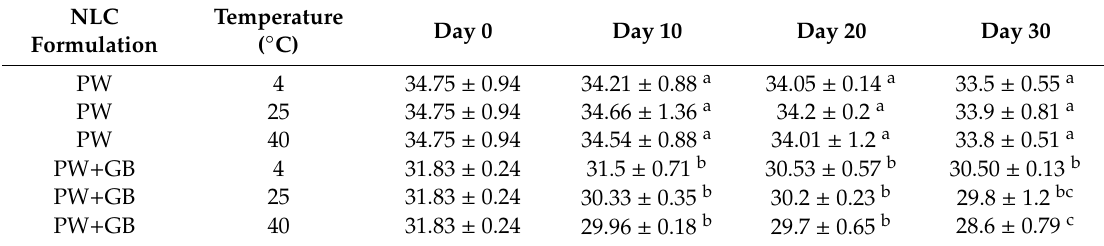
Table 1. Changes of antiradical activity (%) of β -sitosterol NLC dispersions during storage at di ff erent temperatures (4, 25 and 40 ◦